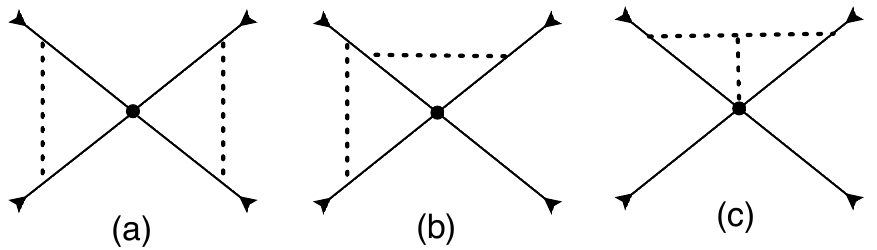
Figure 8 . Representative reduced diagrams for double-soft pinches. In (a) and (b), the denominator of a single line is (cid:12)xed at t and s , respectively, while in (c) two lines are o(cid:11)-shell by s . Single-collinear: a collinear segment in one loop, and unconstrained momentum (cid:15)